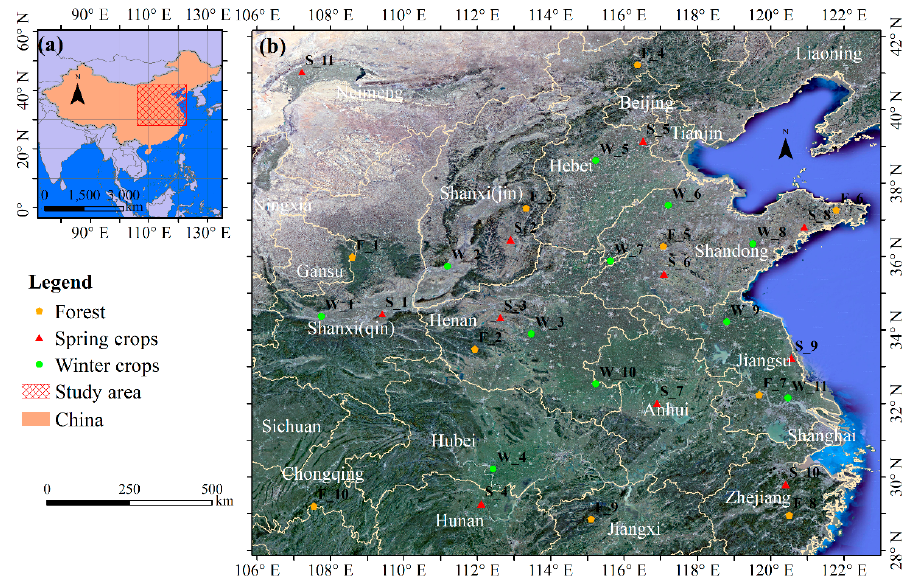
Figure 1. Location of the study area. ( a ) Location of the study area in China; and ( b ) Google Earth-based image of the study area. The dotted symbols represent the sample sites.